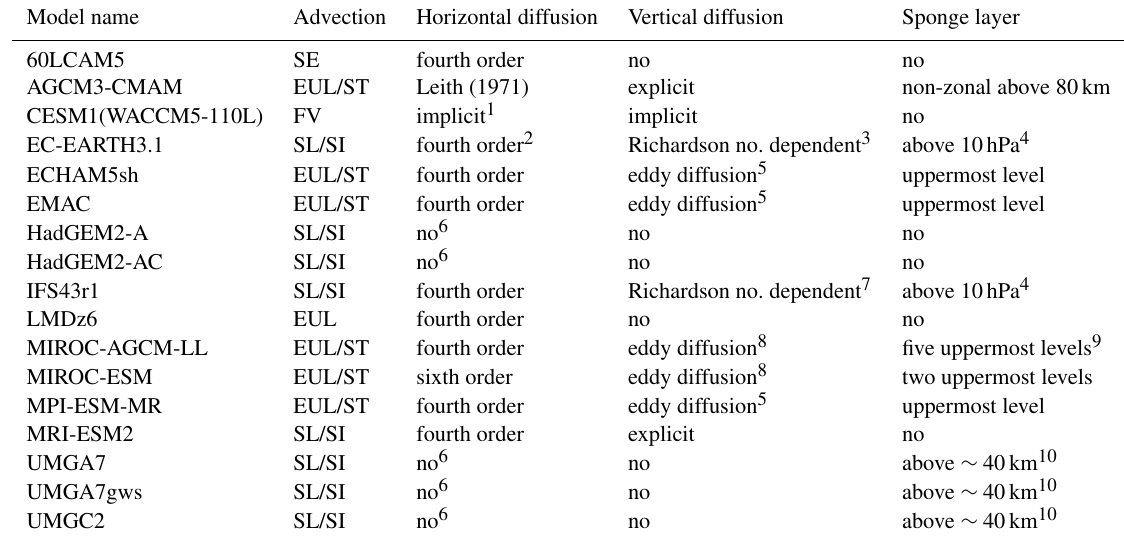
Table 7. Dynamical